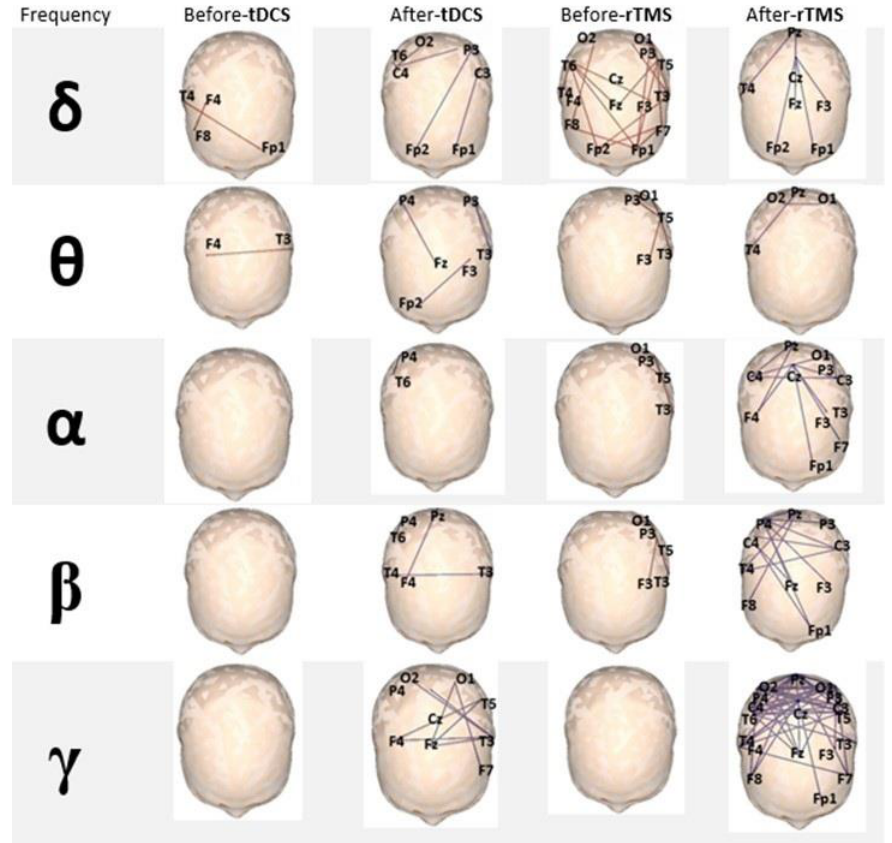
Figure 3. EEG-based analysis of brain functional connectivity. Note the positive change in all frequency bands after the intervention, but mainly in the γ band for both tDCS and rTMS, especially in the group that received rTMS (all electrodes’ locations are statistically significant, p <